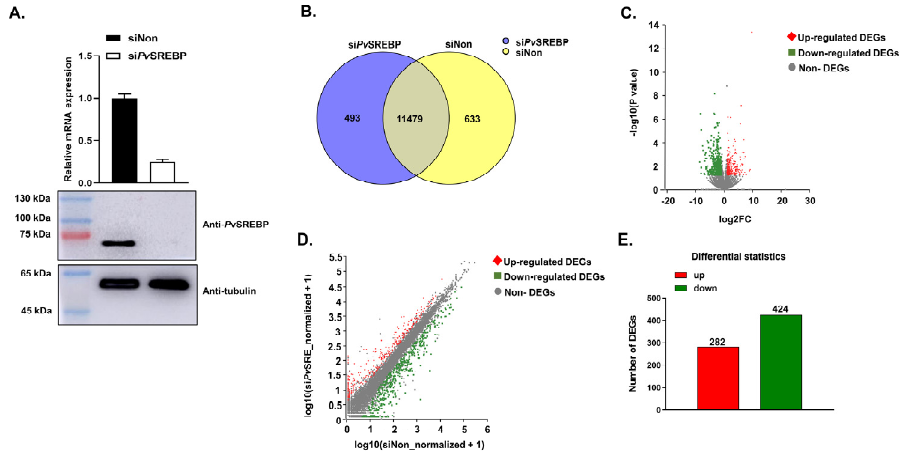
Figure 1. Pv SREBP knockdown and the distribution of differentially expressed genes (DEGs). ( A ) Knockdown efficiency of Pv SREBP determined by qPCR and Western blot analyses. Data represent mean ± SEM ( n = 3). Statistical significance considered at p < 0.05. The immunoblots shown are representative of three independent experiments. ( B ) Number of significantly expressed genes in the two transcriptome libraries. ( C ) Distribution of upregulated and downregulated DEGs. ( D ) Relationship between upregulated and downregulated DEGs. ( E ) Number of upregulated and downregulated DEGs. Table 2. Summary of RNA-seq data for P. vannamei injected with siNon or siPvSREBP.